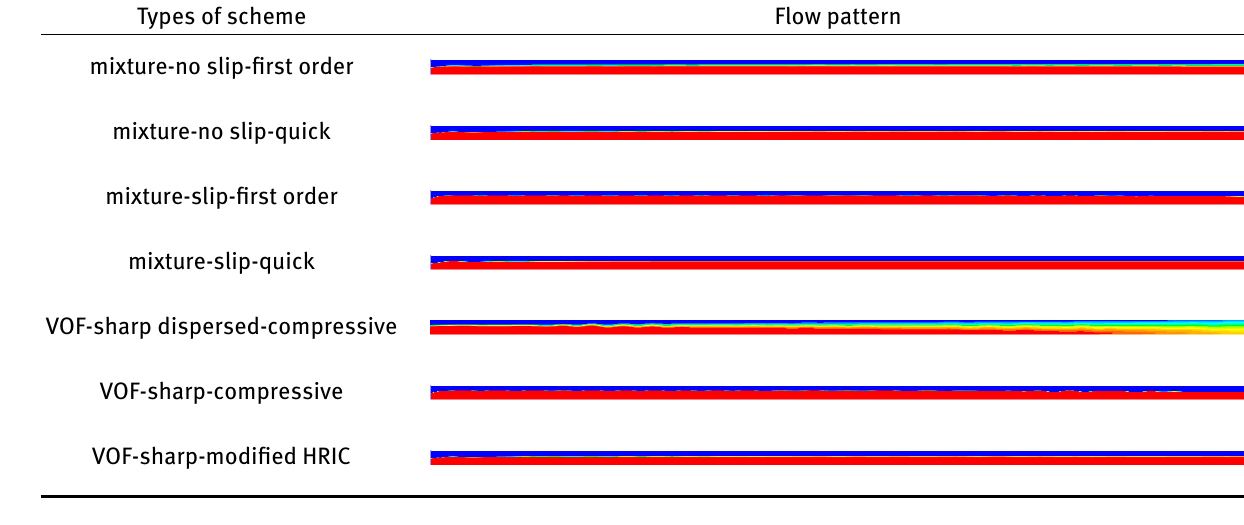
Table 15: Inlet the kerosene above the water for two-phase flow patterns, (L = 3 m, H = 5 cm), mesh (1,040,000) Types of scheme